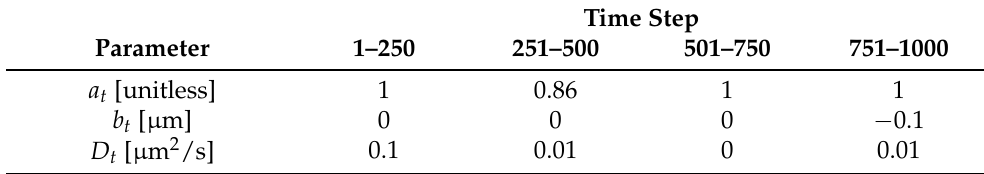
Table 1. Synthetic motion parameter values.